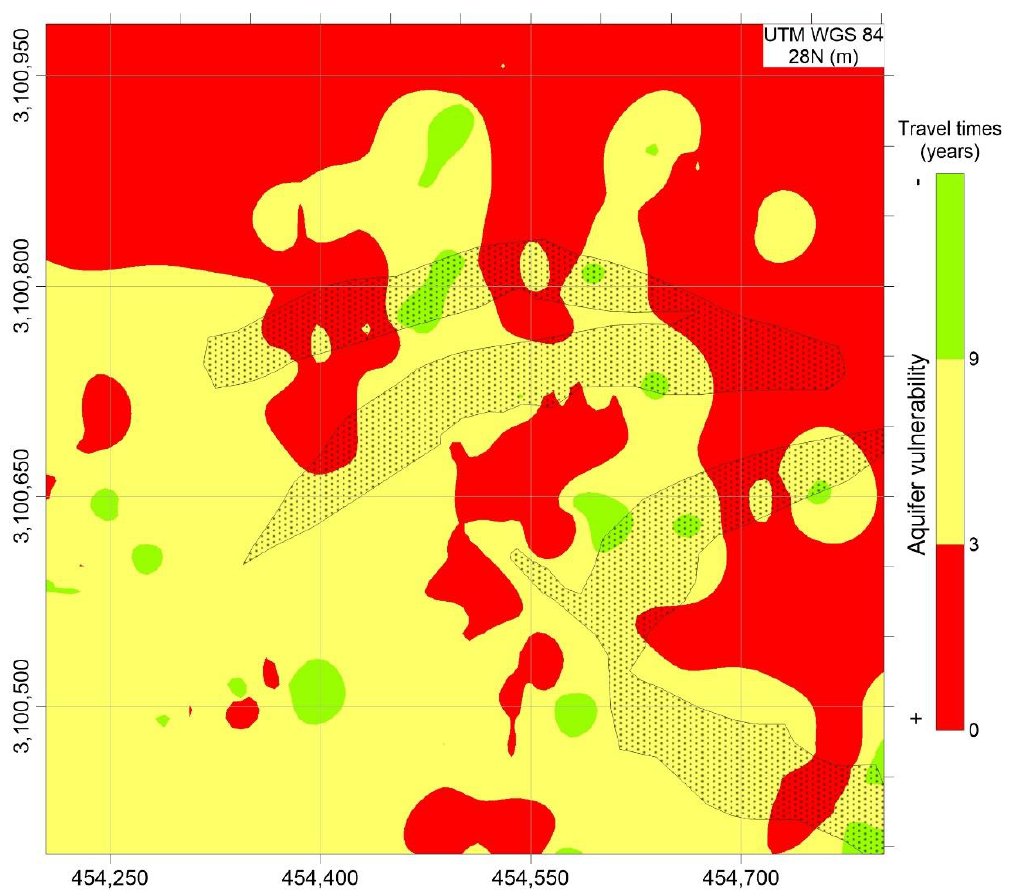
Figure 8. Spatial distribution of travel times of the shallowest 20 m (Bandama Golf Course).